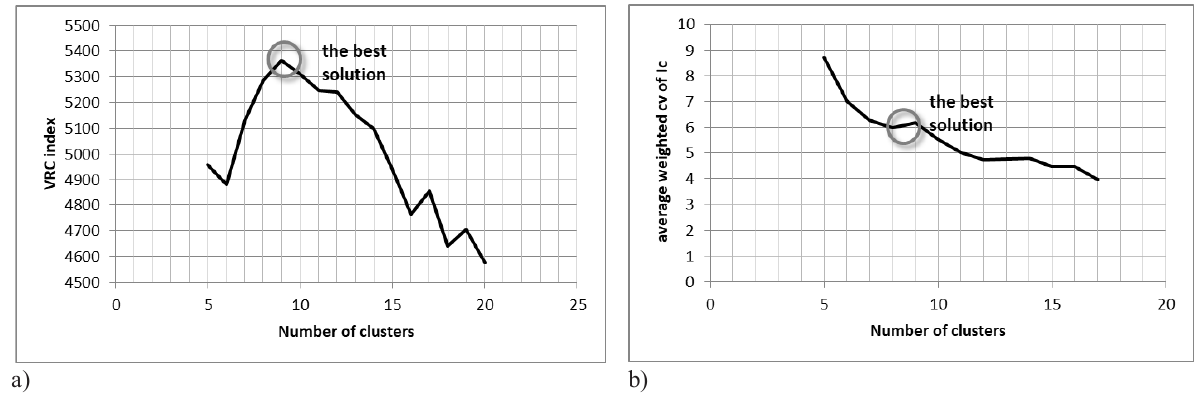
Fig. 4. Indication of optimal cluster number based on the Caliński -Harabasz criterion (a) and the mean weighted coefficient of variation for index I (b). c